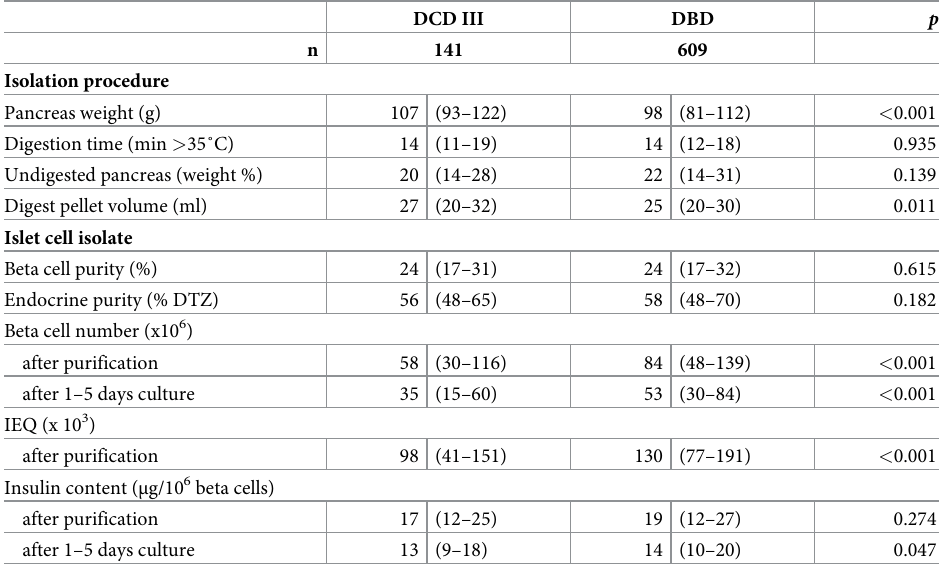
Table 2. Isolation procedure and islet cell isolate characteristics.